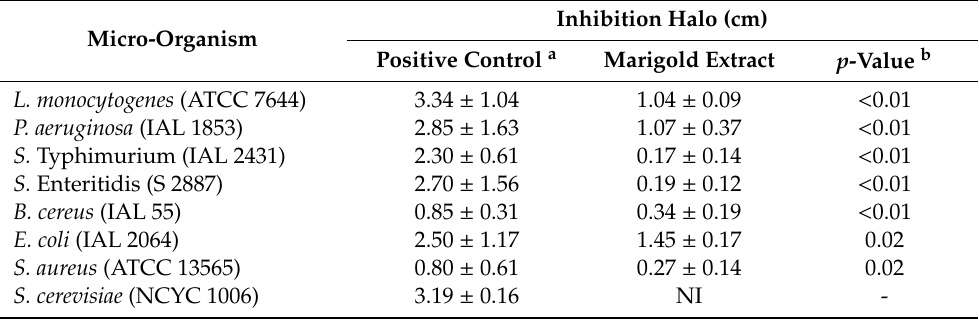
Table 5. Antimicrobial activity of lyophilized marigold extract ( C. o ffi cinalis L.) obtained with water and ethyl alcohol (50:50 v /